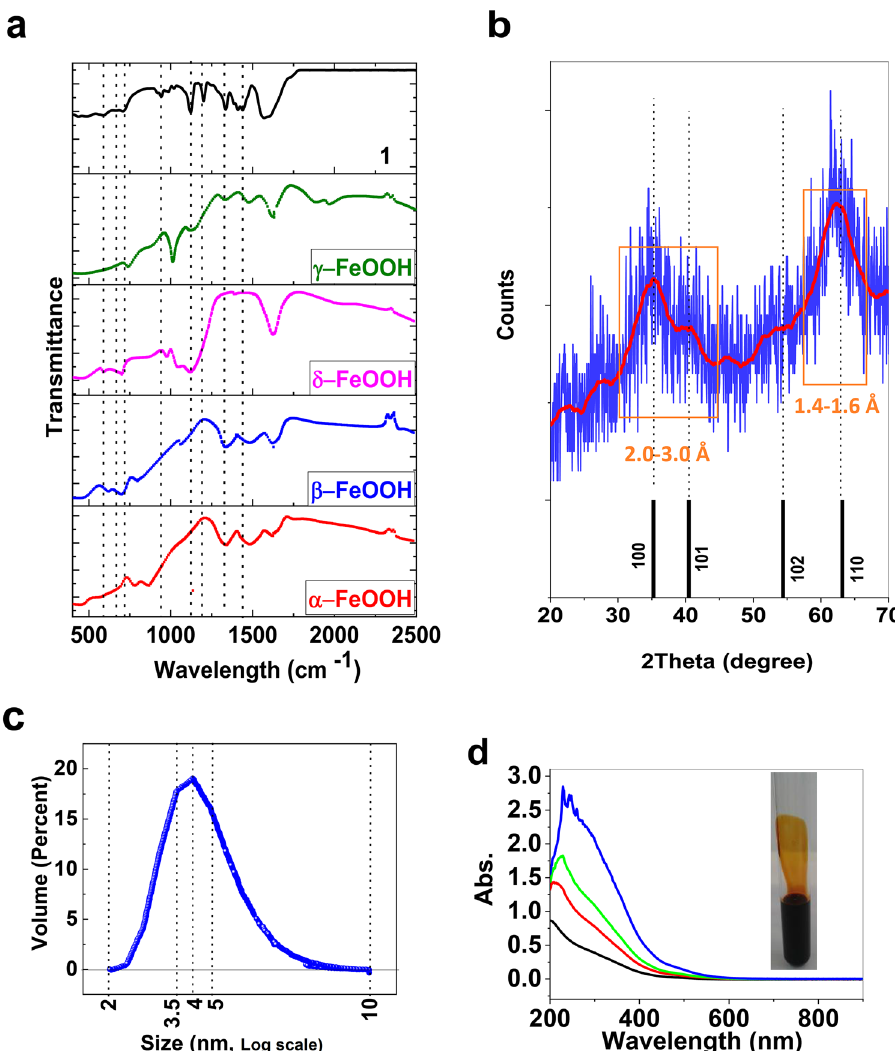
Figure 1. FTIR spectra of α-FeOOH, β-FeOOH, γ-FeOOH, δ-FeOOH, and 1 . The data of FTIR spectra for different FeOOH phases are from ref. 20 ( a ). XRD patterns for 1 (blue) and δ-FeOOH (black) (Ref. code.: 00–013-0518) ( b ). The smoothing XRD pattern for 1 is shown in red ( b ). DLS for 1 (13 μM) ( c ). UV–Visible spectra of 1 22.4 nM (black), 33.6 nM (red), 44.8 nM (green), and 67.2 nM (blue) ( d ). Insert showed a photograph of 1 in a test